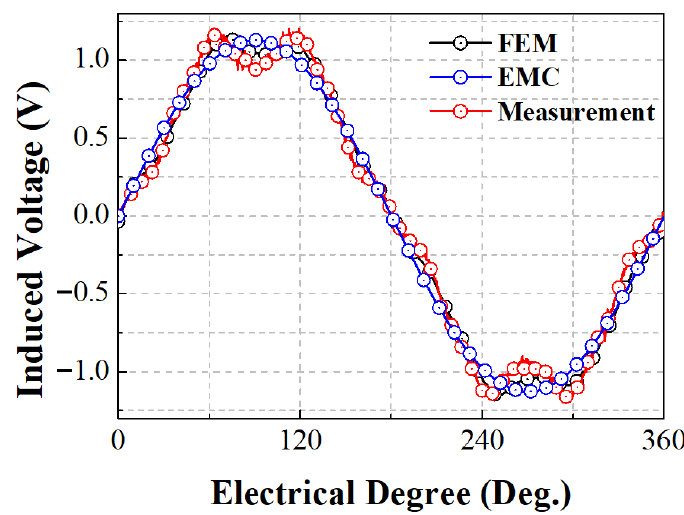
Figure 12. The results of the back-EMF measurement.